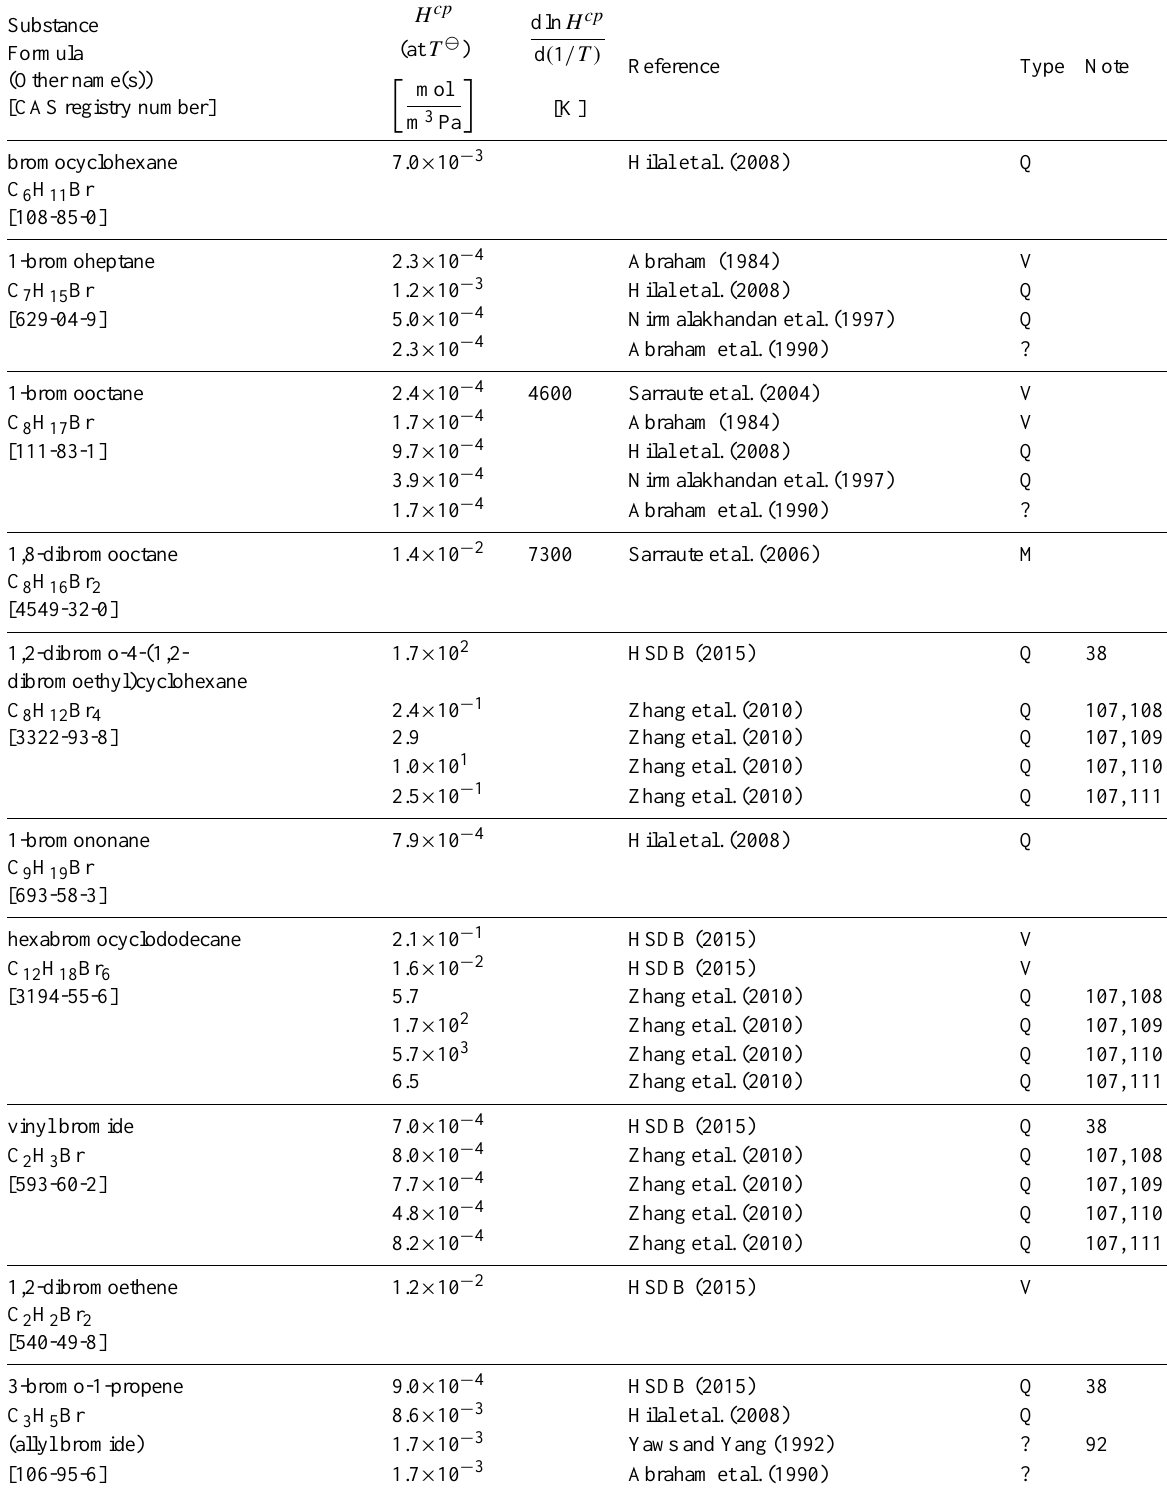
Table 6: Henry’s law constants for water as solvent